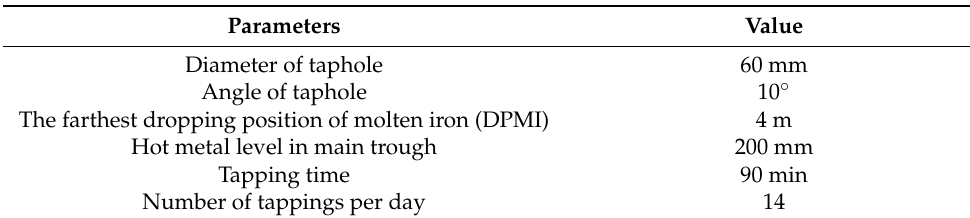
Table 2. Tapping parameters of No. 2 BF in Lai Steel.